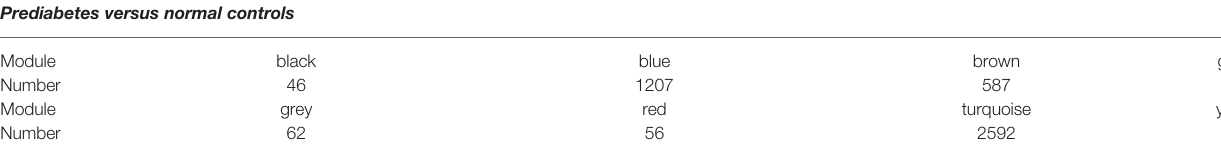
Figure 5C indicated that PI3K-Akt signaling pathway, Cortisol synthesis and secretion, TNF signaling pathway and other signaling pathway were enriched. Activating transcription factor 6- b (ATF6B) was enriched in all above pathways and the corresponding lncRNA was ENST00000485392. All enriched signaling pathways of ATF6B were displayed in Tables S4 and S5 .